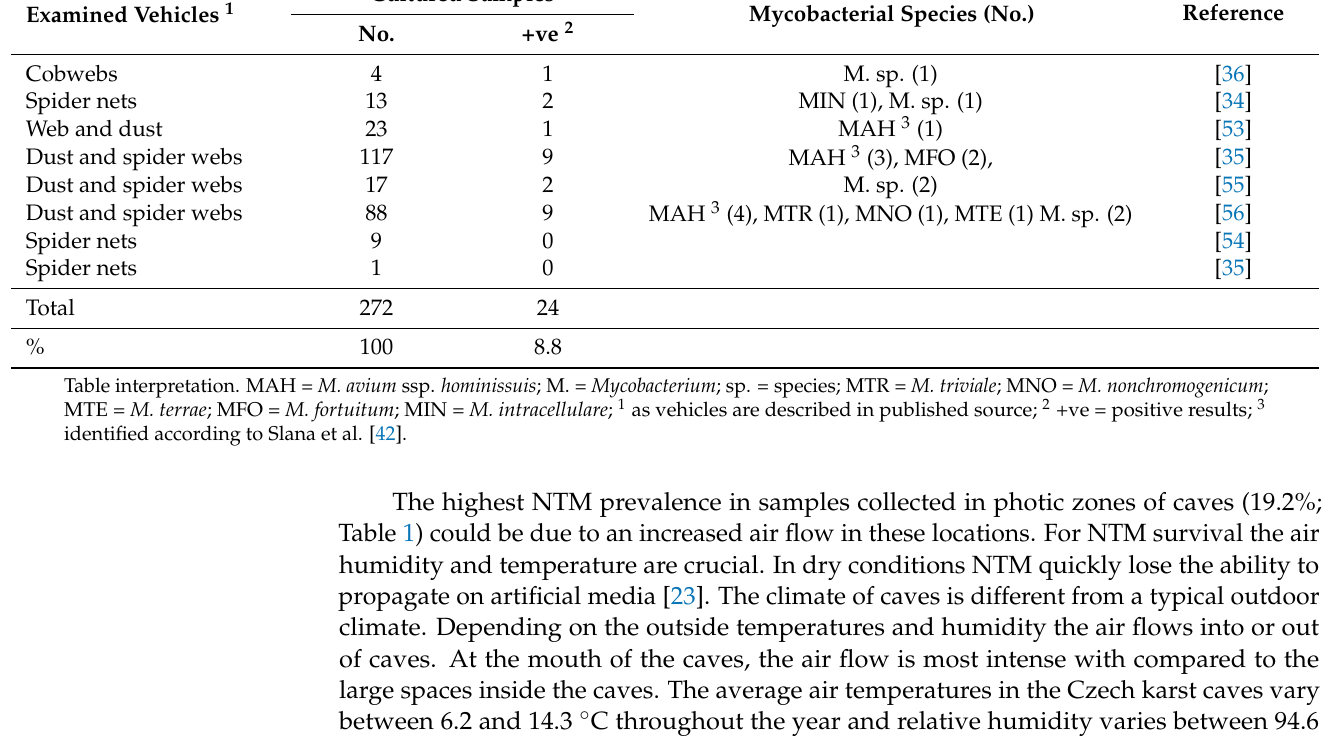
Table 6. Mycobacterial species detection in examined spider’s webs on karst surface and in photic and aphotic zones of caves.